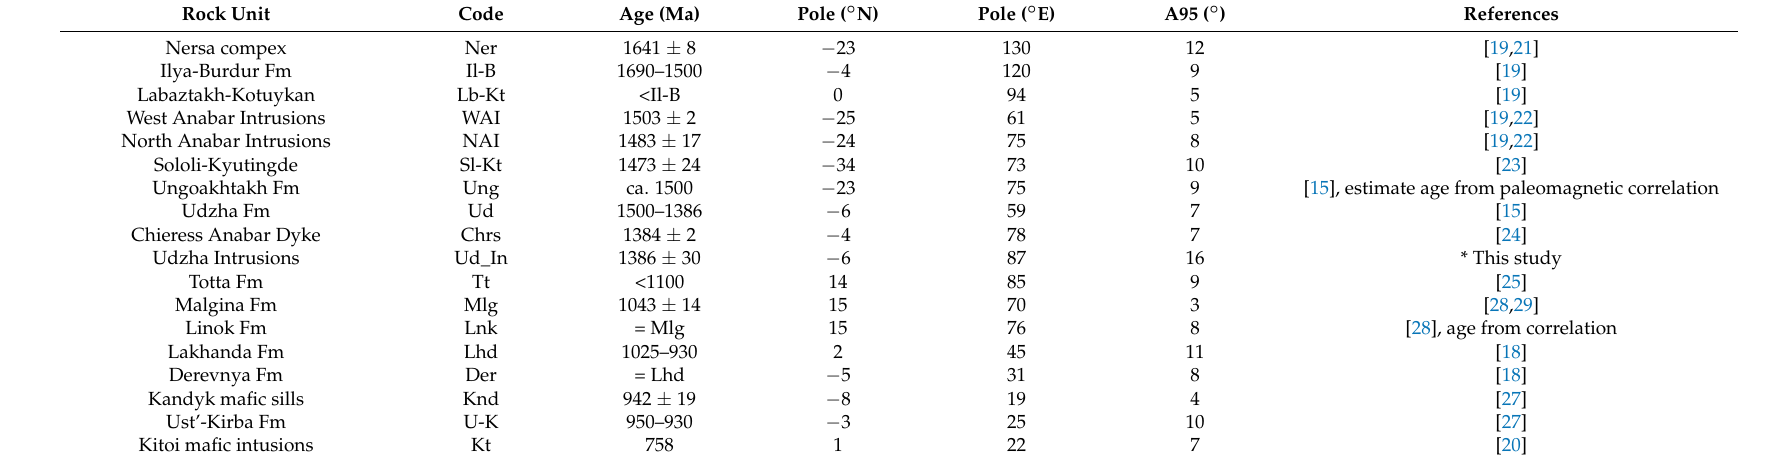
Table 2. Precambrian paleomagnetic poles for Siberian Craton shown in Figure